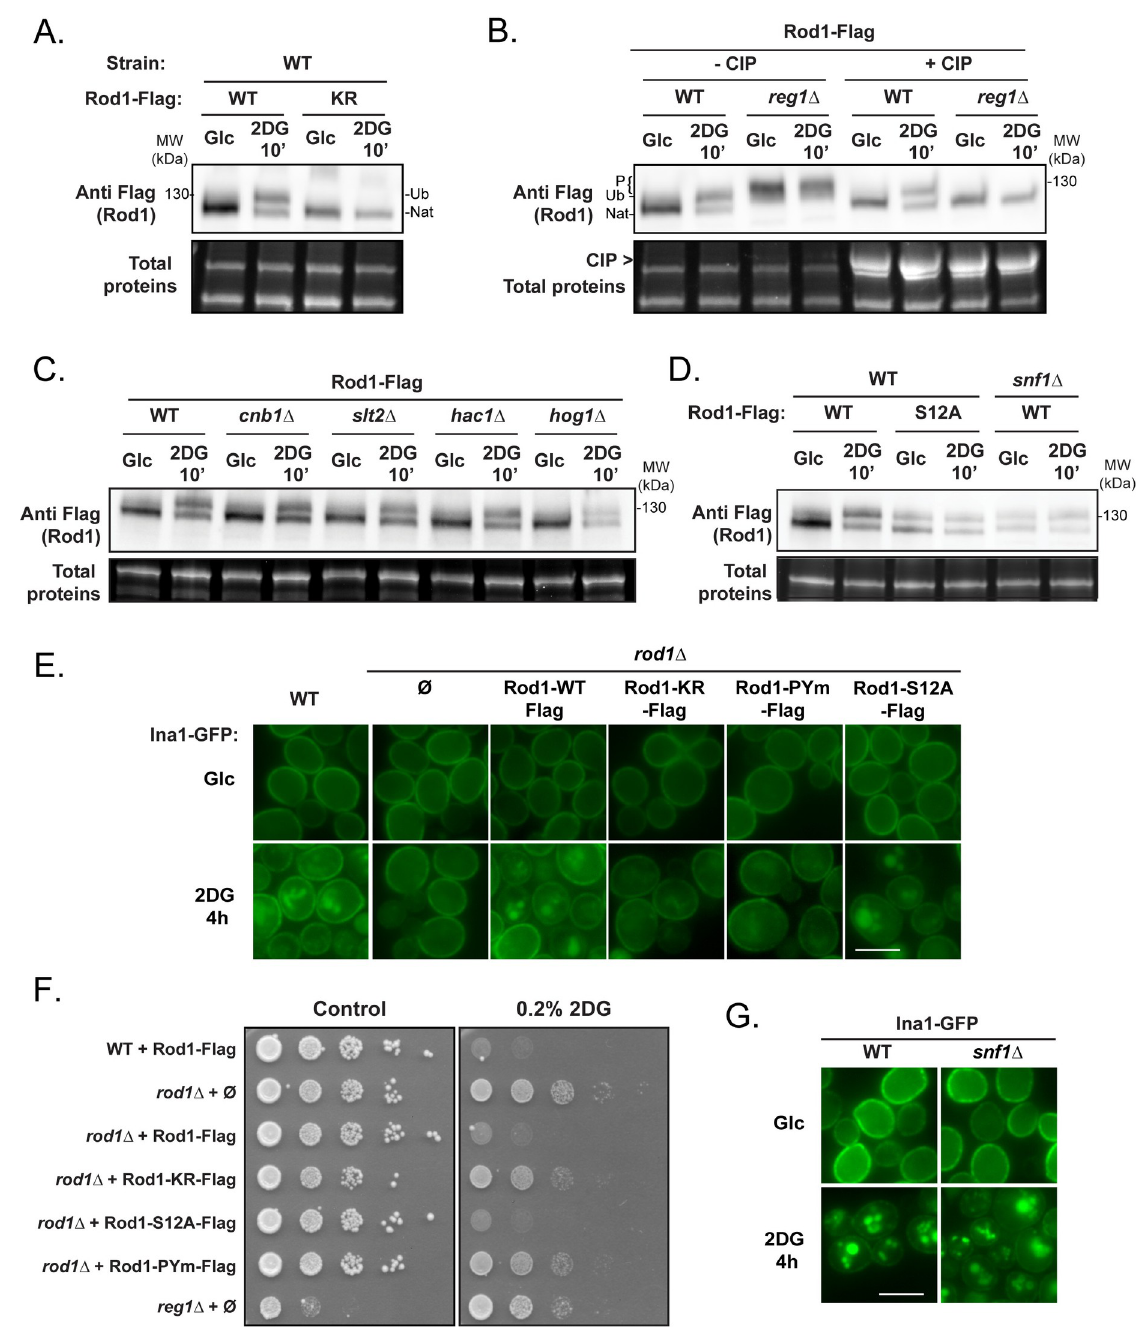
Fig 2. Following 2DG treatment, Rod1 is dephosphorylated in a PP1-dependent manner. (A) Total protein extracts of WT cells expressing either Rod1-Flag or Rod1-KR-Flag were prepared before and after 2DG addition for 10’, and immunoblotted using an anti-Flag antibody. Ub: ubiquitylated Rod1, Nat: native Rod1. (B) Total protein extracts of WT or reg1 Δ cells expressing Rod1-Flag were prepared before and after 2DG addition for 10’, and immunoblotted using an anti-Flag antibody. Samples were dephosphorylated by CIP where indicated. Ub: ubiquitylated Rod1, Nat: native Rod1, P: phosphorylated Rod1. (C) Total protein extracts of WT, cnb1 Δ , slt2 Δ , hac1 Δ , or hog1 Δ expressing Rod1-Flag were prepared before and after 2DG addition for 10’, and immunoblotted using an anti-Flag antibody. (D) Total protein extract of WT or snf1 Δ cells expressing Rod1-Flag or Rod1-S12A-Flag were prepared before and after 2DG addition for 10’ and immunoblotted using an anti-Flag antibody. (E) WT or rod1 Δ cells expressing the various ROD1- Flag constructs were grown in a glucose- containing medium and observed by fluorescence microscopy before and after 2DG treatment for 4h. Scale bar, 5 μ m. (F) Serial dilutions of cultures of the indicated strains were spotted on SC medium or SC + 0.2% 2DG medium and grown for 4 days at 30˚C. (G) WT or snf1 Δ cells expressing Ina1-GFP were grown in a glucose-containing medium and observed by fluorescence microscopy before and after 2DG treatment for 4h. Scale bar, 5 μ